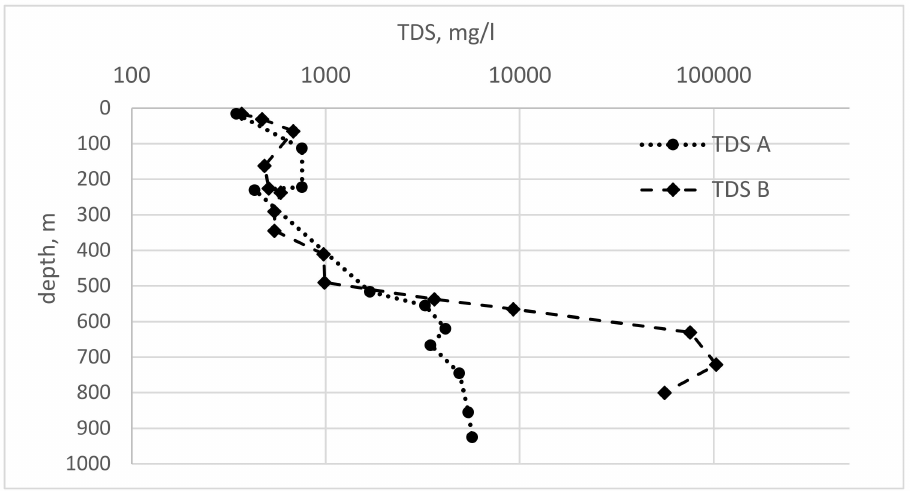
Figure 4. Total dissolved solids (TDS) profile in boreholes A and B. Key hydrogeological parameters of different formations are shown in Table